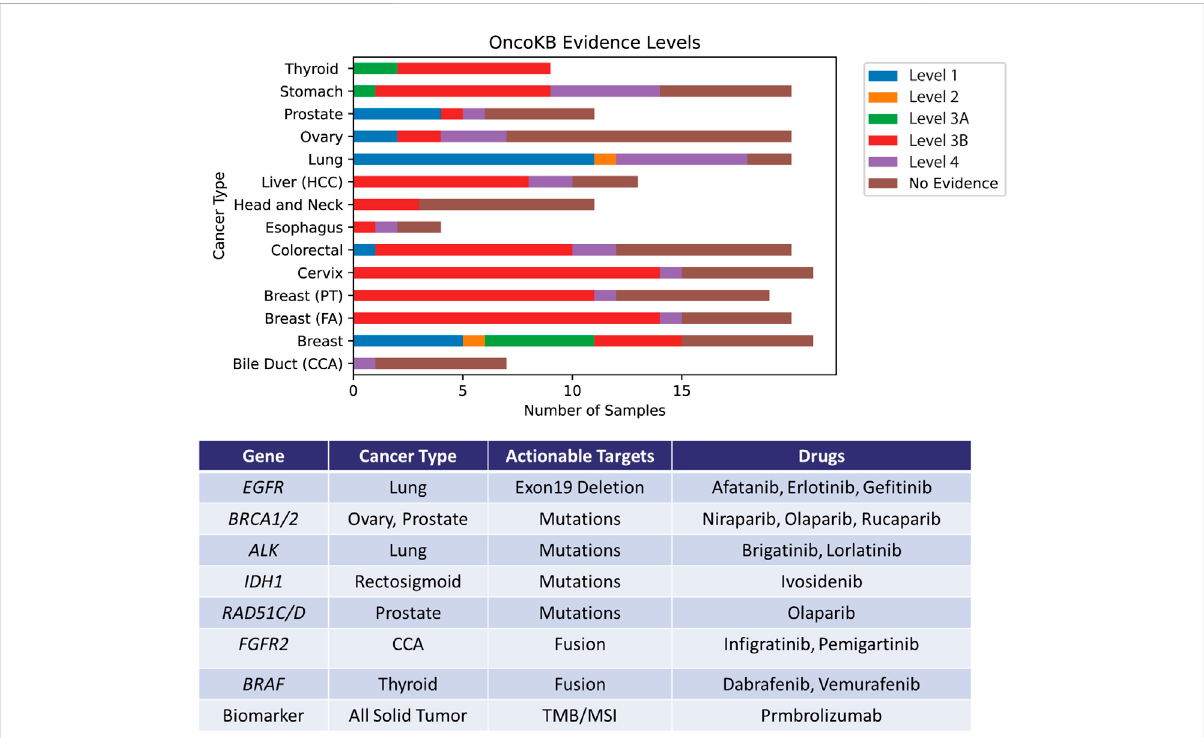
FIGURE 5 Identi fi cation of actionable mutations by the Asian Pan-Cancer Assay by cross-referencing OncoKB database. The levels portrayed depicts varyingvaryingdegrees ofactionability basedonOncoKB evidenceacrossthevarious cancersubtypespro fi ledinthisstudy.Examplesofpotentially applicable drugs matched to the actionable targets are shown in the